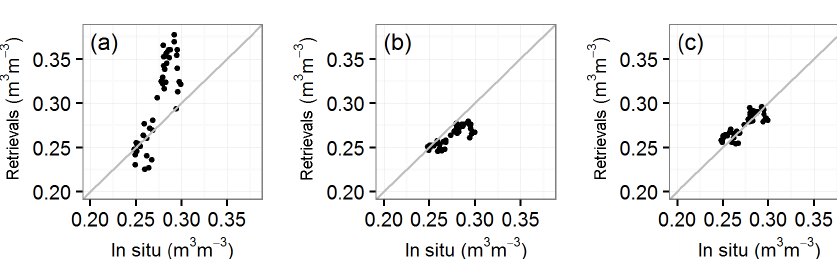
Figure 4. VSM GPS retrievals ( N = 47) vs. daily mean in situ VSM observations (m 3 m − 3 ) at 5cm from 16 January to 5 March 2015, (a) with the a priori slope S = 0.0148m 3 m − 3 ◦− 1 , VSM = 0.0148 (cid:49)φ + 0.252, (b) with the locally adjusted slope S = 0.0033m 3 m − 3 ◦− 1 , VSM = 0.0033 (cid:49)φ + 0.252 and (c) from scaled soil wetness indexes, VSM = 0.055 φ index + 0.247. More scores can be referred from Table 1.